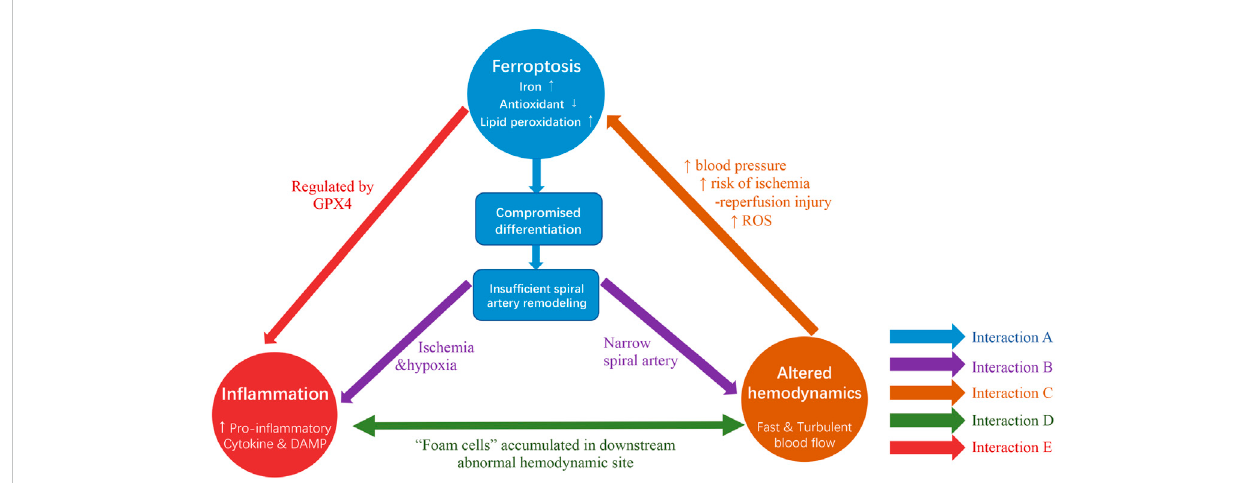
FIGURE 3 The interactions among ferroptosis, in fl ammation and altered hemodynamics co-contribute to the pathogenesis of PE. (A) Ferroptosis, characterized by iron overload, antioxidants depletion and lipid peroxidation, is potential to contribute to compromised trophoblast cell differentiation and consequently results in suboptimal spiral artery remodeling. (Arrows shown in blue). (B) On one hand, ferroptosis resultant suboptimal remodeling exposes ischemia and hypoxia environment to the placenta and poses threats to the in fl ammatory response. On the other hand, inadequate spiral artery remodeling characterized by narrow spiral artery formation leads to altered hemodynamics (Arrows shown in purple). (C) This fast and turbulent blood fl ow is likely to promote ferroptosis, as it might contribute to high maternal blood pressure, increased risk of ischemia-reperfusion injury and soared ROS level (Arrow shown in orange). (D) In fl ammatory response and altered hemodynamics are possible to be inter-connected as evidence suggested the existence of “ foam cells ” accumulated in downstream abnormal hemodynamic locations (Arrow shown in green). (E) An intimate relationship might be exhibited between in fl ammation and ferroptosis due to the presence of GPX4. (Arrows shown in